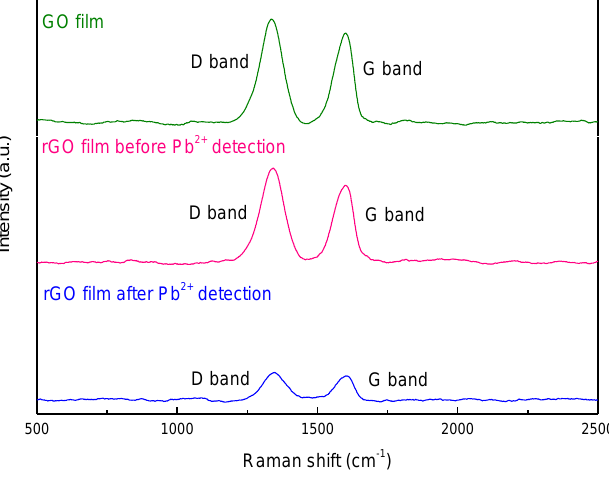
Figure 4. The Raman spectrum of GO film, rGO films before and after Pb 2+ detection.